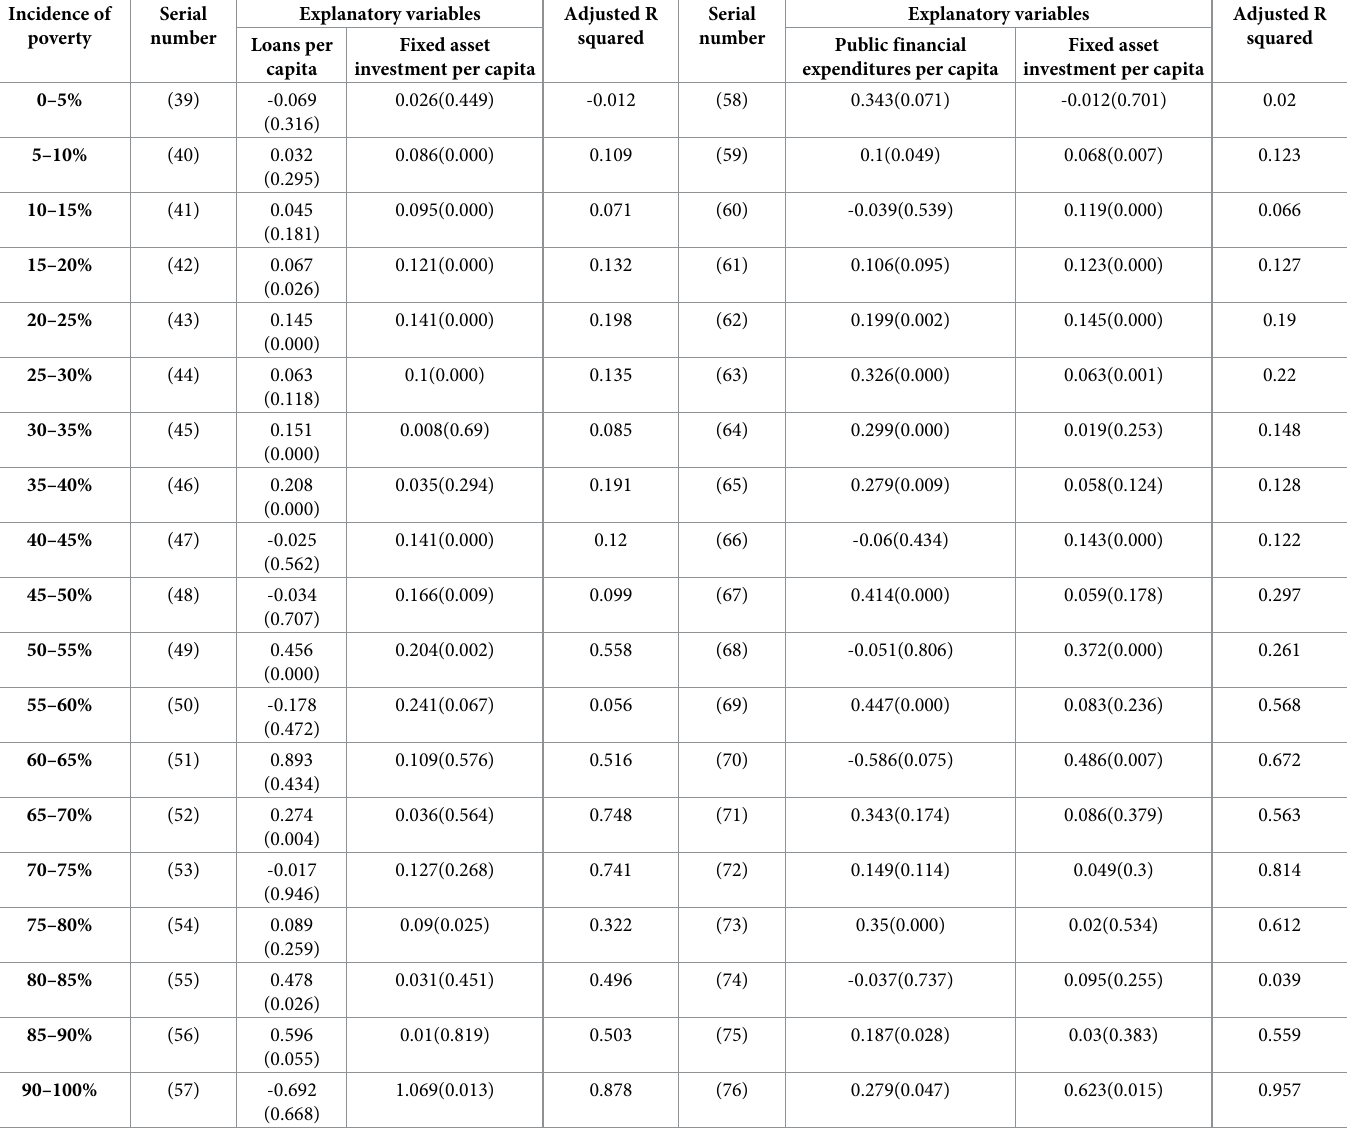
Table 5. The linear relationship between urban per capita income (dependent variable) and the explanatory variables under different poverty incidence. Incidence of